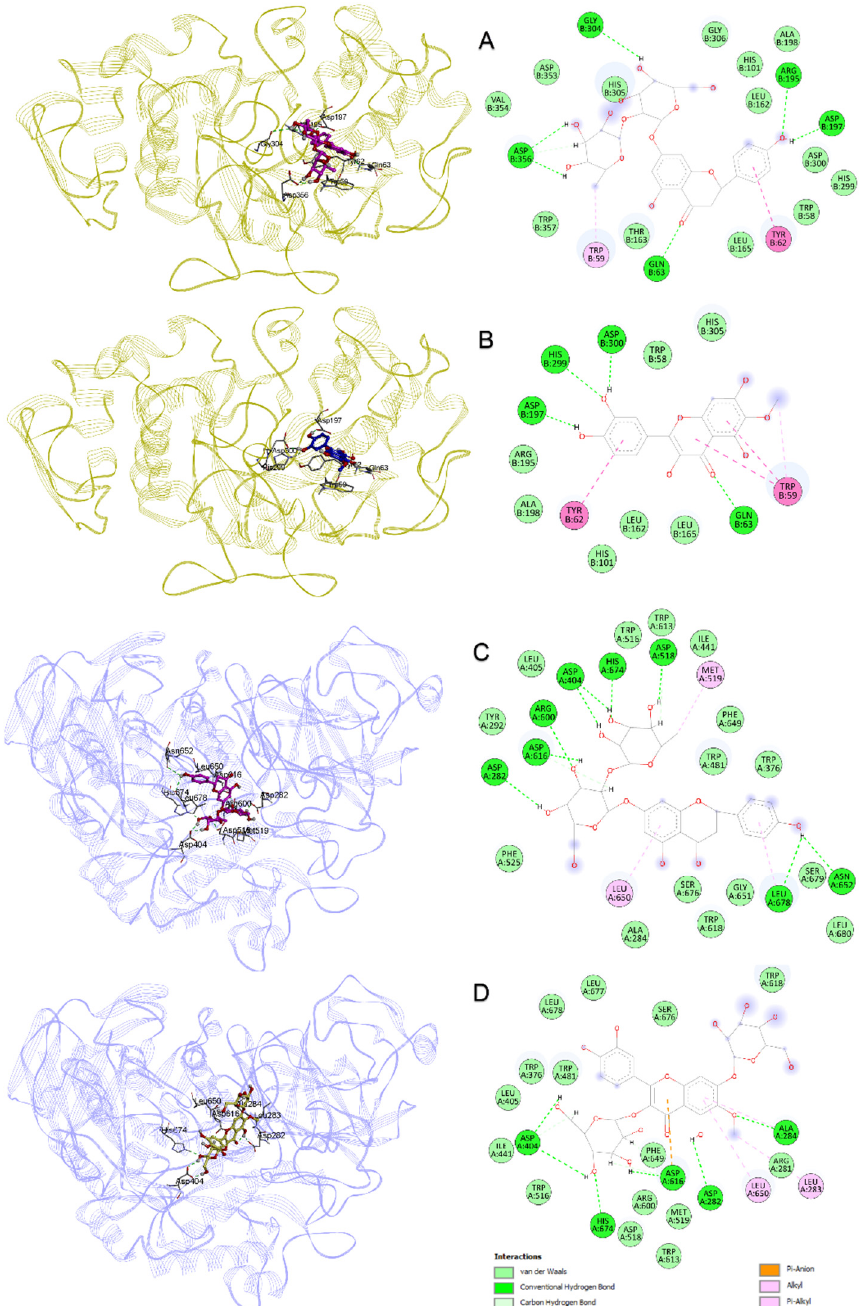
Figure 4. Binding poses and interaction diagram obtained from molecular docking: ( A , B ) compounds naringin and patuletin with α -amylase; ( C , D ) naringin and patuletin 3,7-diglucoside with α -glucosidase. Table 6. Molecular docking interaction energies (kcal/mol) of the acarbose and compounds detected with the LC-MS analysis from the TFE sub-extract against the target enzymes, α -amylase and α - glucosidase.